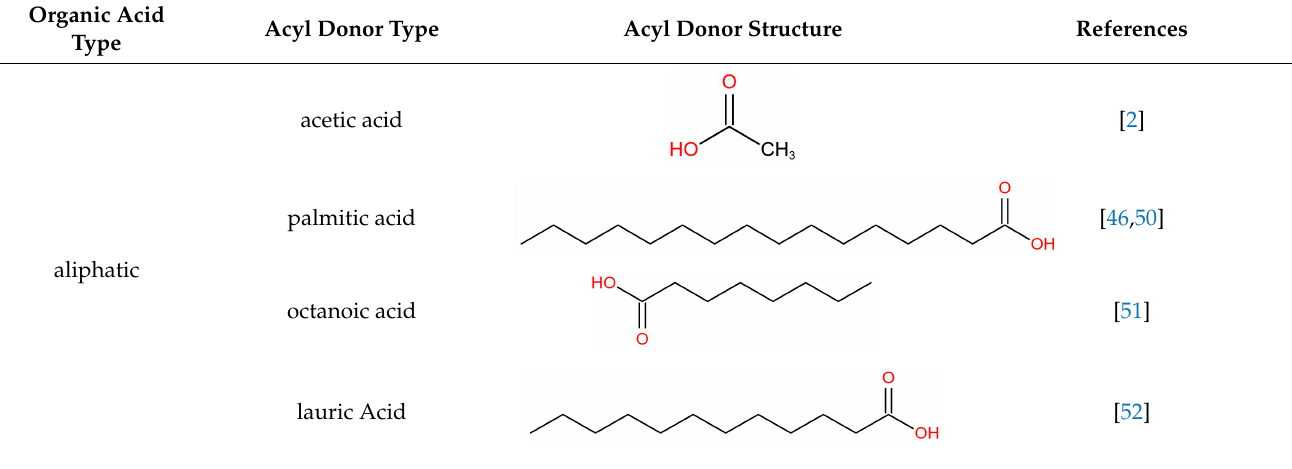
Table 1. Acylation modification of anthocyanins by organic acids. Organic Acid